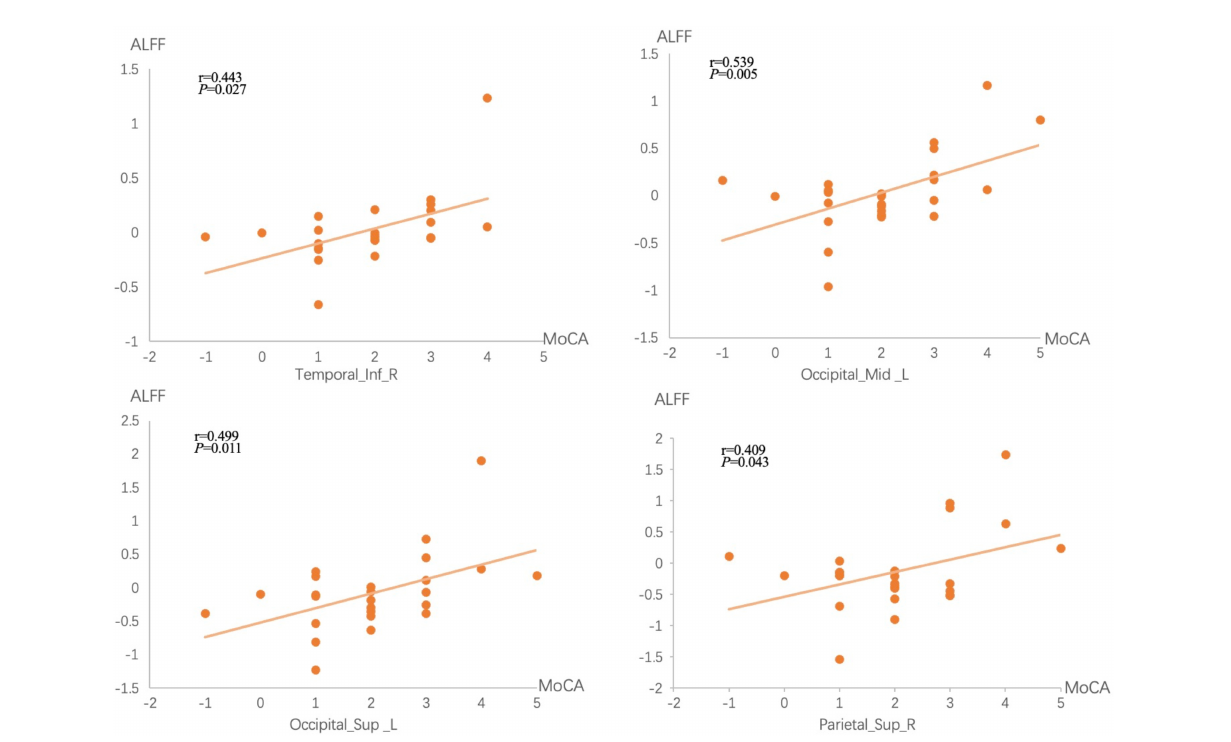
FIGURE4 Correlations between brain measures and treatment performances. The x -axis represents the difference in MoCA scores before and after treatment, while the y -axis represents ALFF values differences before and after treatment.